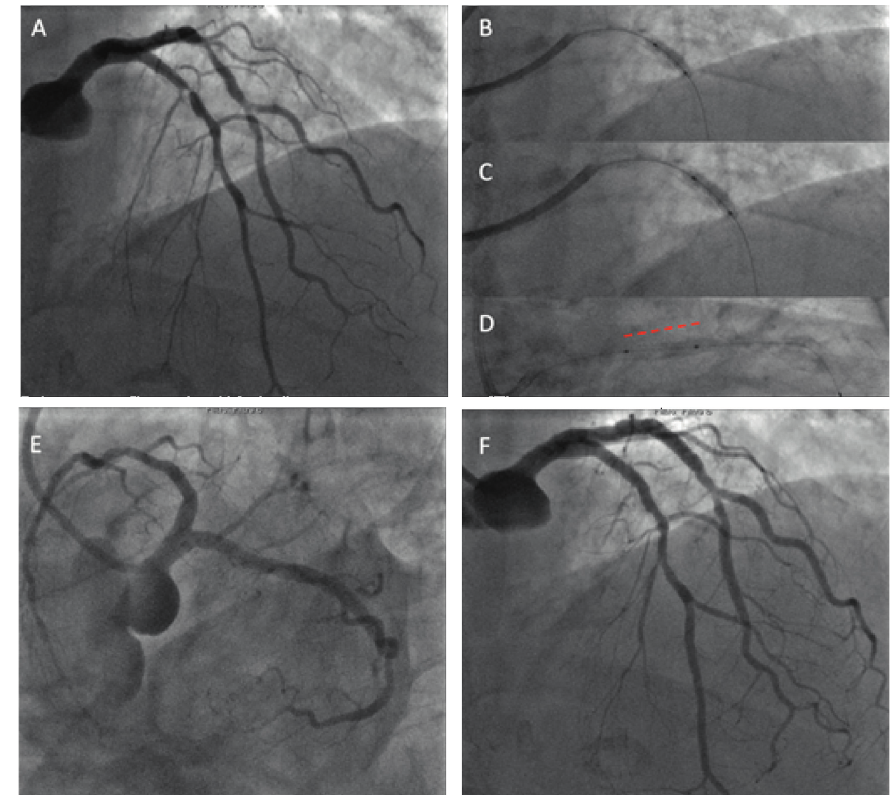
Figure 2: STEMI patient undergoing PCI with the SCB of ISR lesion on LAD. A patient with anterior STEMI for ISR on LAD (a) underwent PCI with a 2.75 × 12mm noncompliant balloon (b), 3.0 × 15mm noncompliant balloon (c), and 3.0 × 15 mm SCB (d), with good final angiographic result and TIMI 3 flow ((e) and